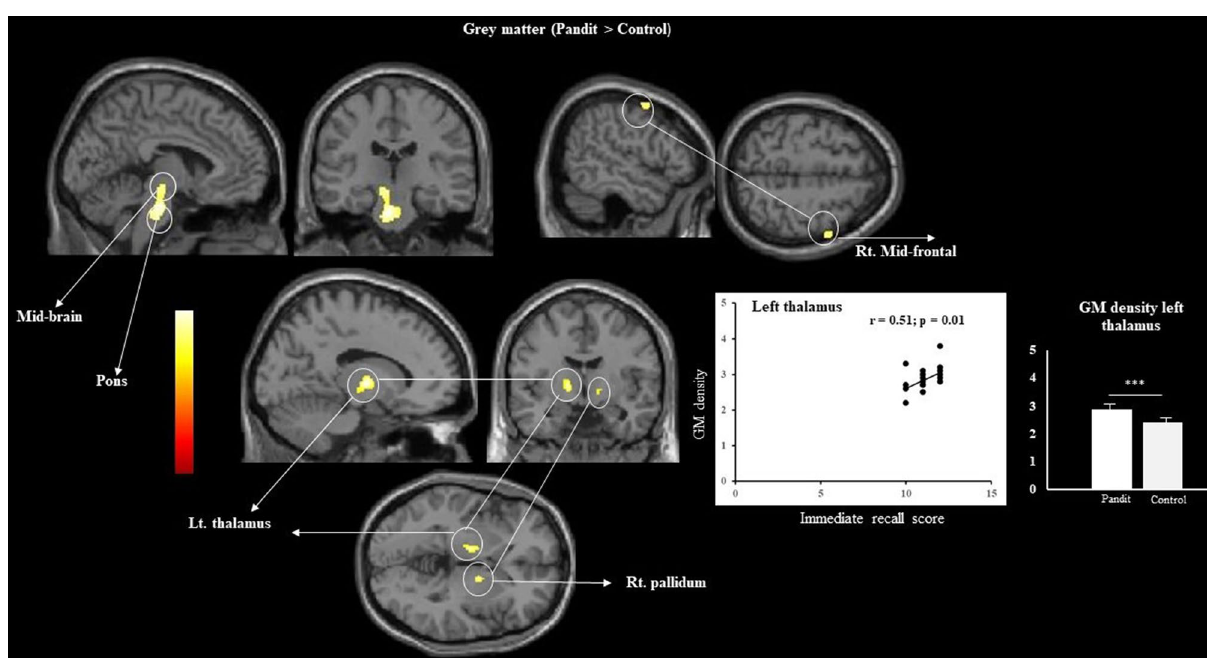
Figure 1. Results of VBM group comparison. The result rendered into standard stereotactic space and superimposed on to transvers, sagittal and coronal section of magnetic resonance image (MRI) which is itself in standard space. The image shows increased GM value in Pandit/Priest as a result of the two-sample t -test comparing with the Control, at a threshold of P < 0.05 (FWE) corrected. The figure also specifies GM density differences in two group and result of corelation analysis between GM density and immediate recall behaviour